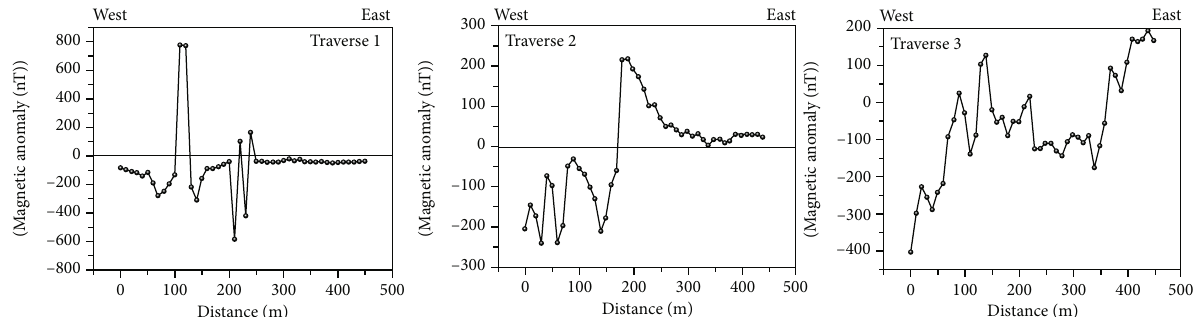
Figure 9: Source data on magnetic anomalies for the prediction of faults (ground magnetic data obtained along traverses 1, 2, and 3)